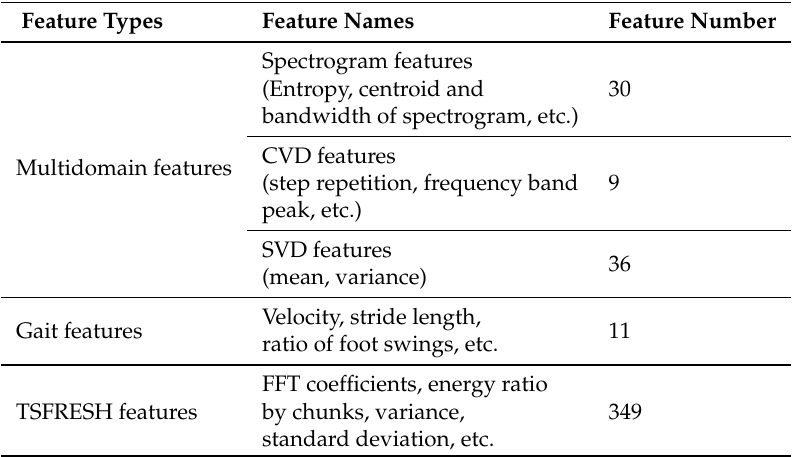
Table 8. Summary of features extracted for the personnel recognition task.